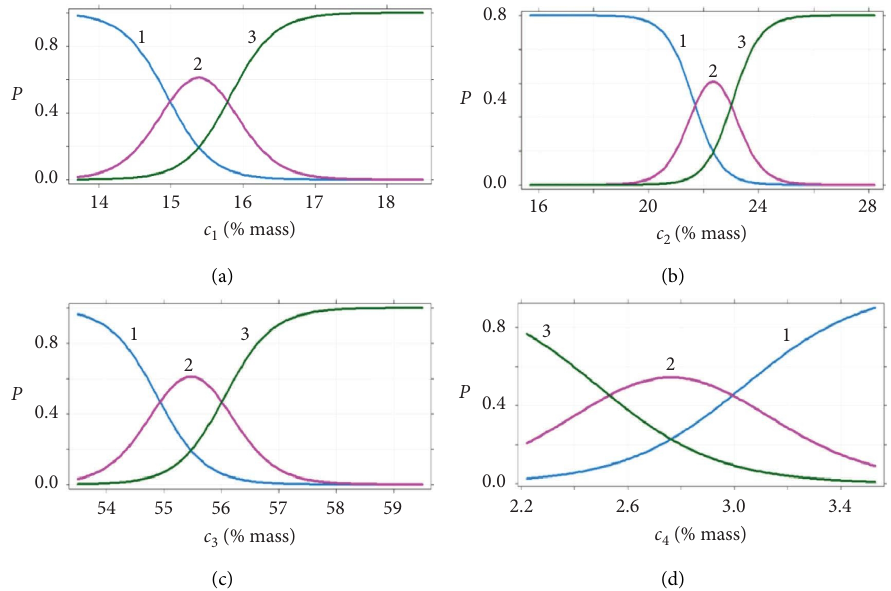
Figure 5: Probabilities P of responses of diferent taste categories in dependence on content of (a) protein c (d) salt c 4 , mass fractions, %. Each plot is calculated at contents of other main components equal to their observed mean values in Table 4. Te line numbers are as in Figure 2.